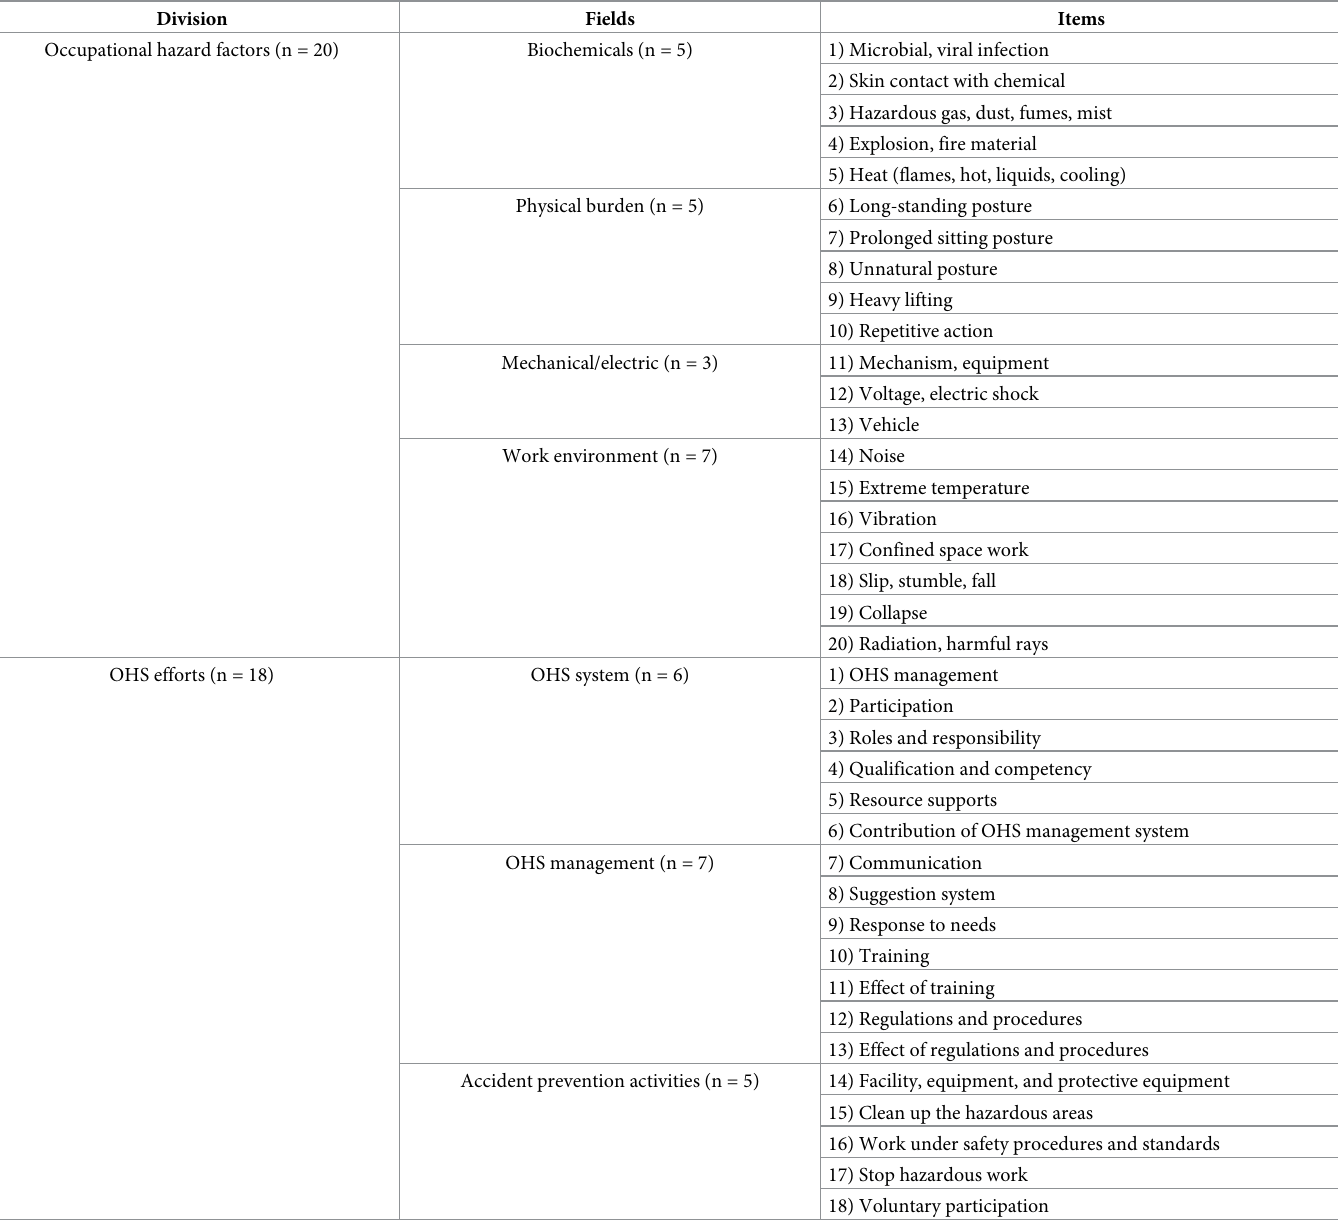
Table 1. Occupational hazard factors and OHS efforts questionnaire items (number of questions).